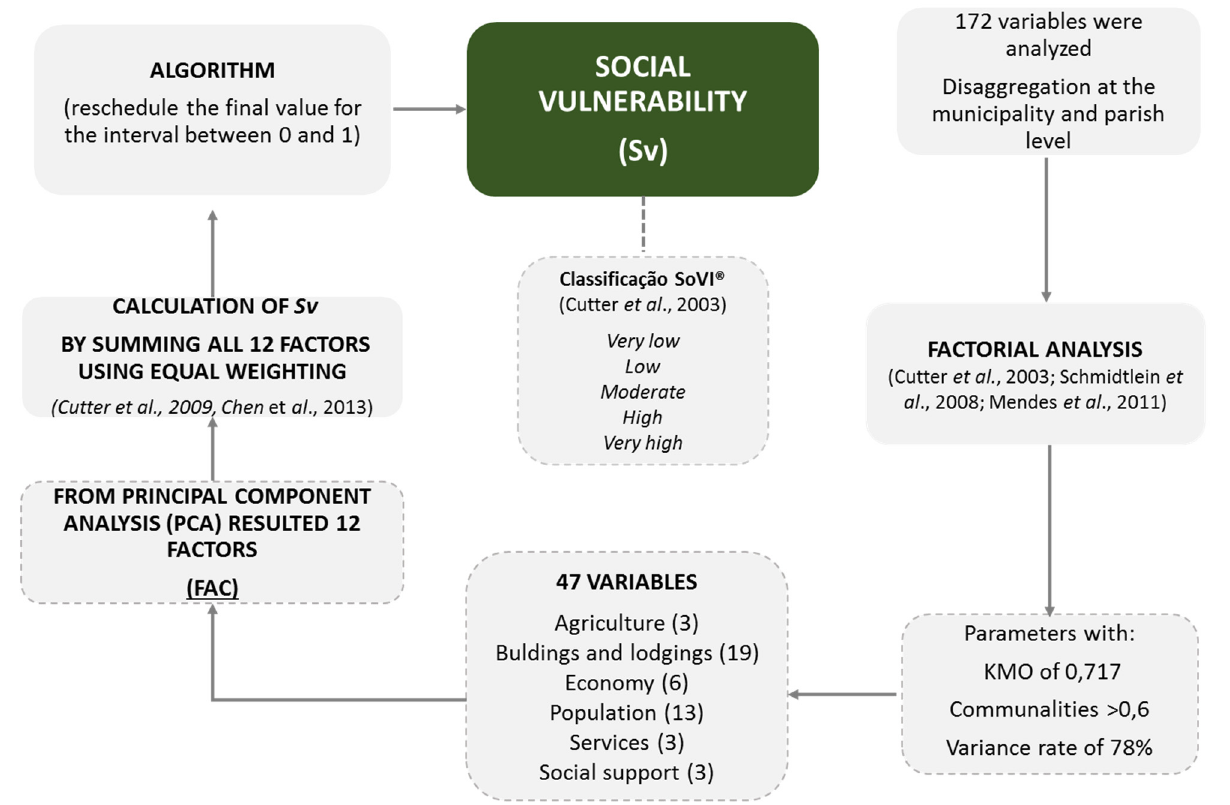
Figure 7. Graphical process of social vulnerability calculation.